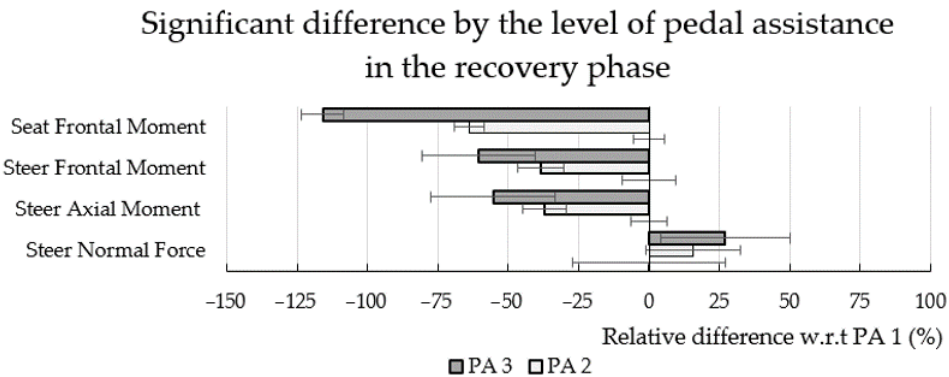
Figure 10. Significant differences based on the level of PA for the recovery